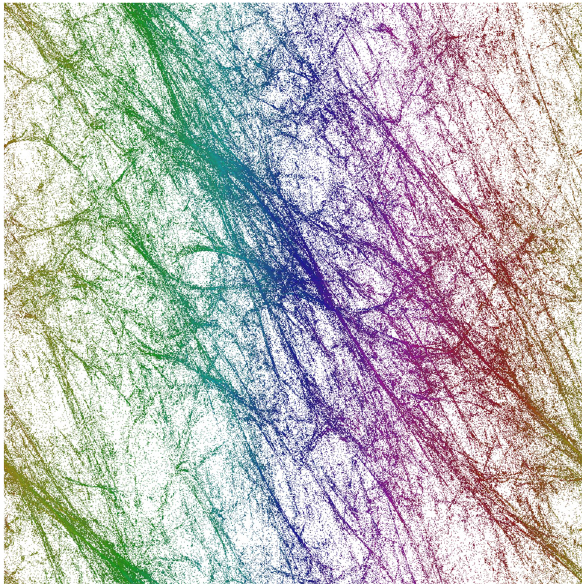
Fig. 1 The projection of four-volume on the xy -plane, as defined by (11) for a CDT configuration. Different colors correspond to different times t of the original t -foliation